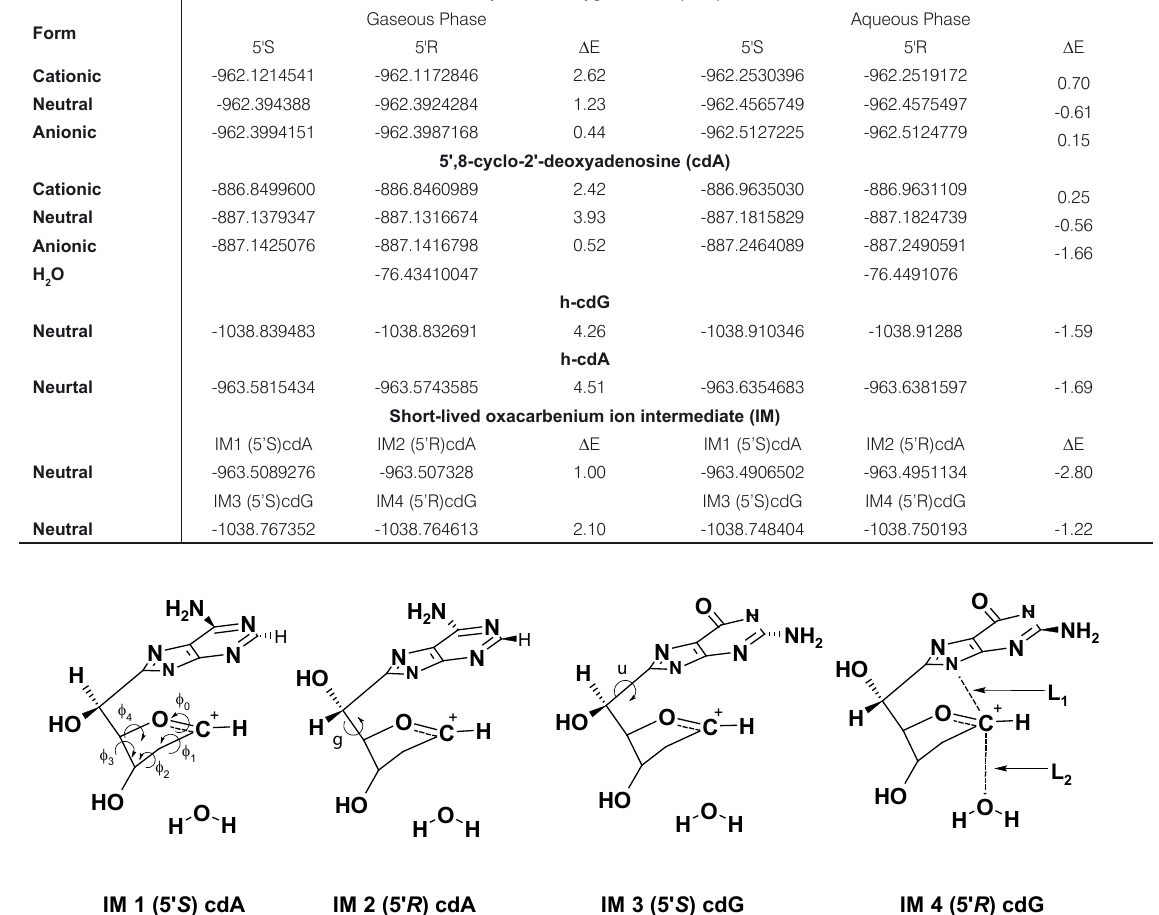
) and nucleophile – carbenium ion (L 1